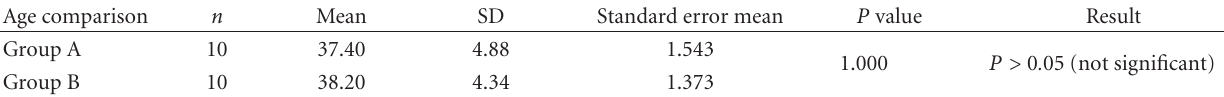
Table 2: Percentage of distribution of gender in both